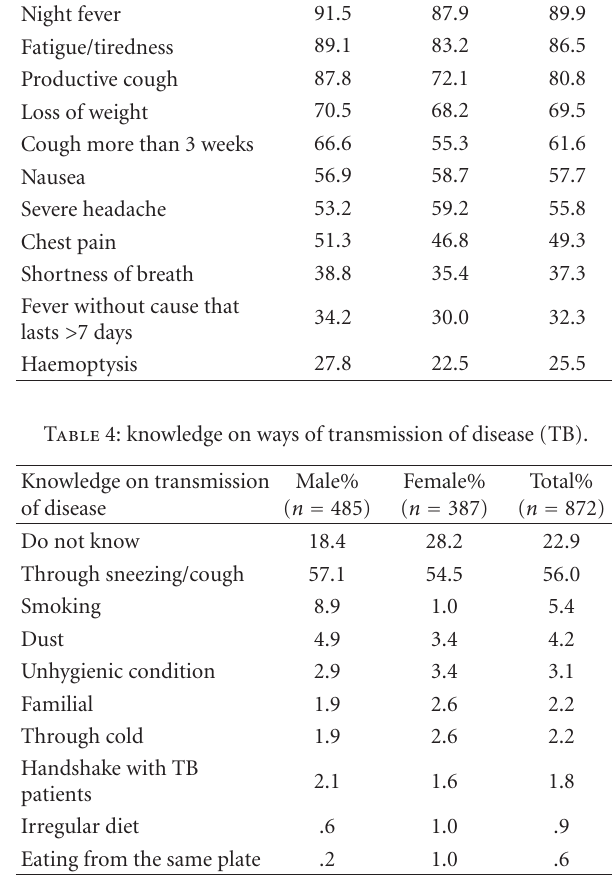
Table 7: Perception on being a TB